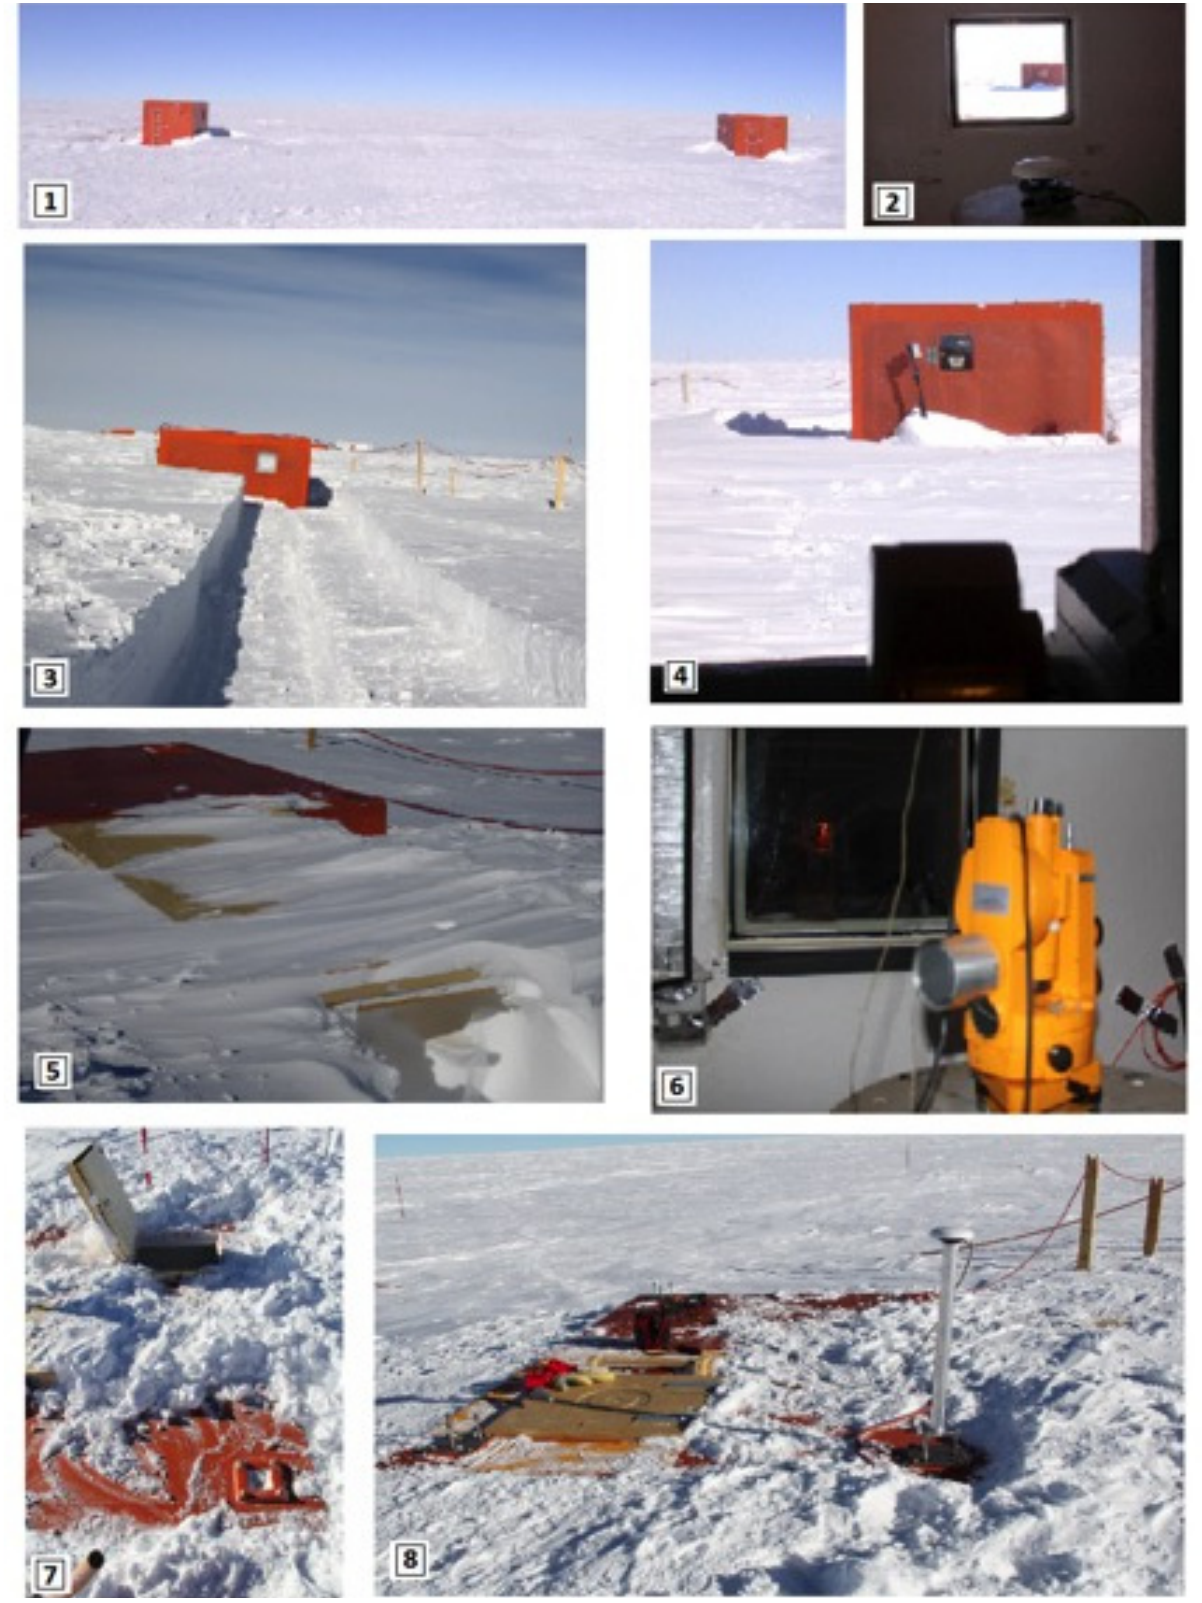
Figure 2. A compilation of pictures taken along the last decade at Concordia station. In particular: 1) Two amagnetic shelters hosting the au- tomatic instrumentation and the pillar respectively as they appeared in 2005; 2) the shelter with automatic instrumentation and azimuth mark fixed on the external wall, visible from the opposite shelter; 3) a trench in the ice facilitated some activities at the shelters and surrounding areas; 4) an enlarged view of the azimuth mark; 5) full snow coverage of one of the two shelters and wooden plates laying over the shallow tunnel (not visible). The picture was taken in 2010; 6) the dark shallow tunnel (back), the illuminated azimuth mark and the geomagnetic theodolite placed over the pillar (close-up); 7) a trapdoor mounted on the roof of one of the two embedded shelters, used as entrance; 8) new external asset for GNSS survey, in preparation for future recordings. An aluminum pole as stand for the receiver antenna screwed on